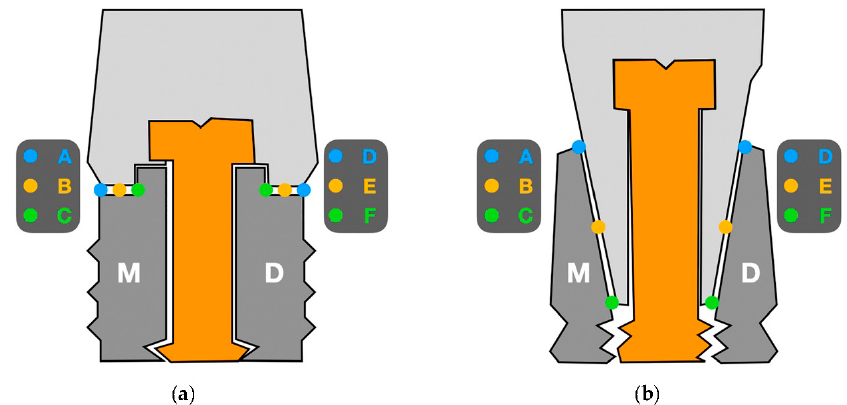
Figure 1. Scheme of the positions used for measuring the implant-abutment interface: ( a ) external connection, ( b ) Morse taper connection.